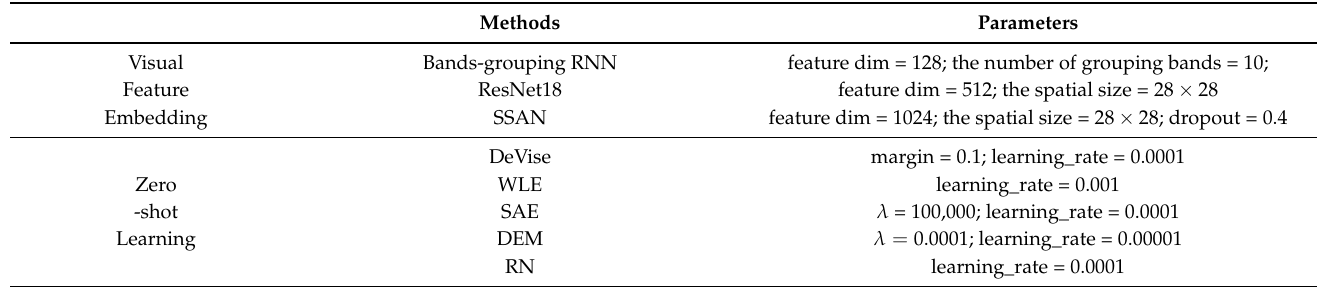
Table 4. Parameter configurations for comparative methods.